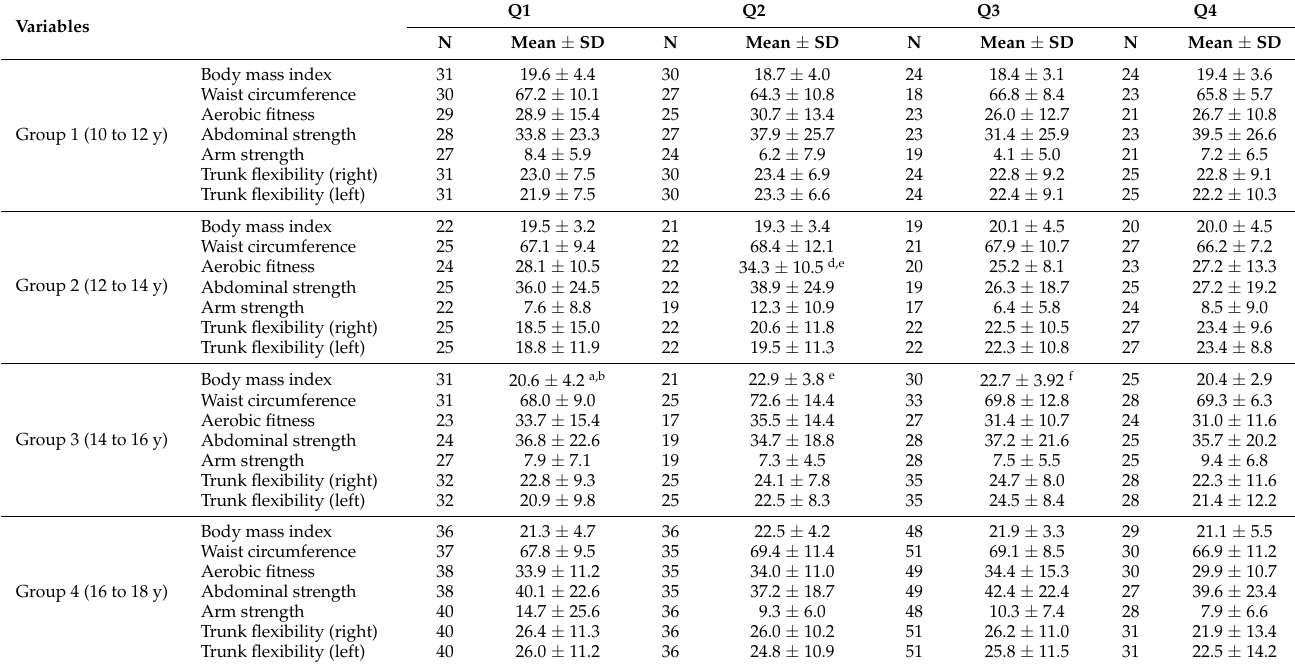
Table 1. Characterization and inferential analysis of the considered variables according to the age group for female participants.